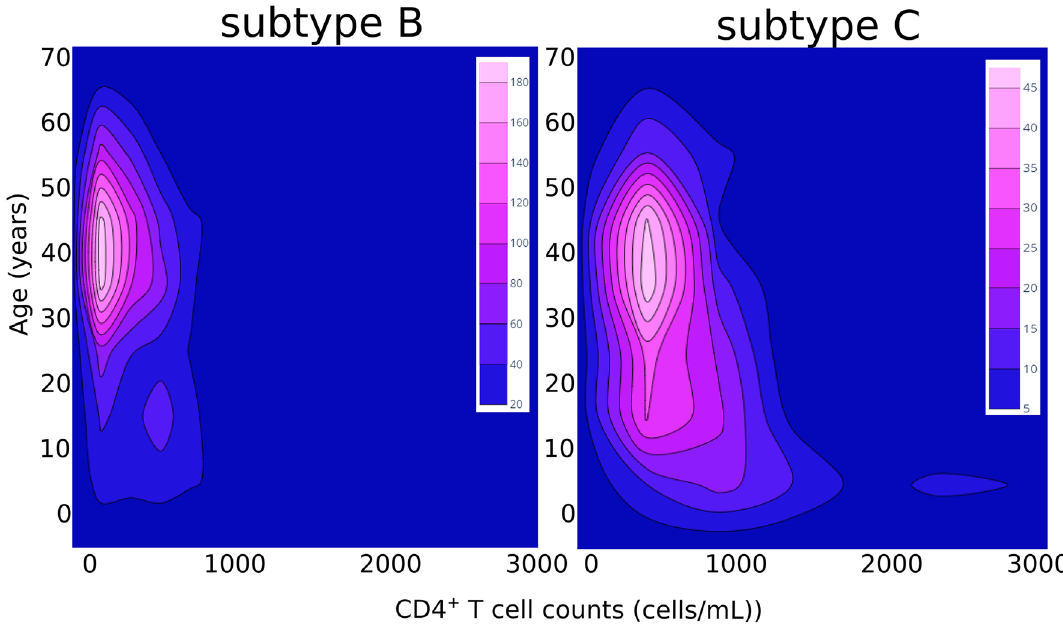
Figure 2. Age and CD4 + T cell counts in individuals infected with HIV-1 subtype B or C. The 2D contour histograms represent the Age (years) in the y axis and CD4 + T cell counts (cells/mL) in the x axis for all studied cases of HIV-1 subtype B infection (n = 1675) and subtype C infection (n = 340). The color scale represents the frequency of cases from blue (lower) to pink